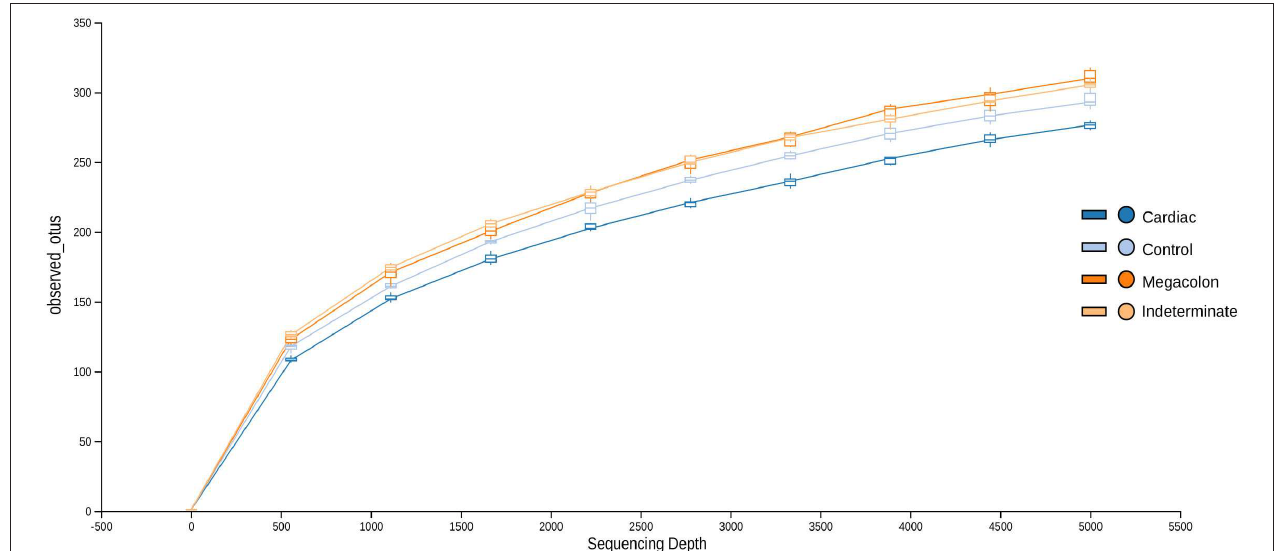
FIGURE 1 | Rarefaction curves demonstrating the estimated number of operational taxonomic units (OTUs) in the microbiome of stool samples of the control group and Chagas disease groups (indeterminate, cardiac, and megacolon phenotypes) as a function of the sequencing effort generated through the QIIME (Quantitative Insights Into Microbial Ecology)